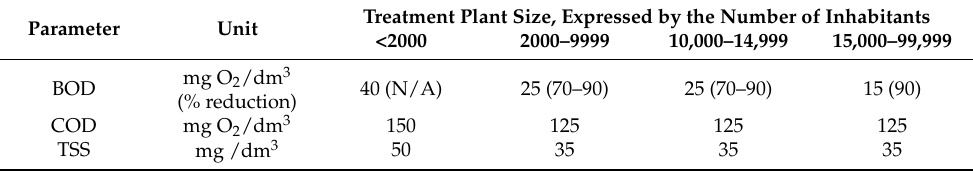
Table 4. The highest permissible values of pollution indicators or the minimum percentages of pollution reduction for domestic and municipal wastewater treatment plants discharged into waters and soils in Poland [29]. N/A—not available.